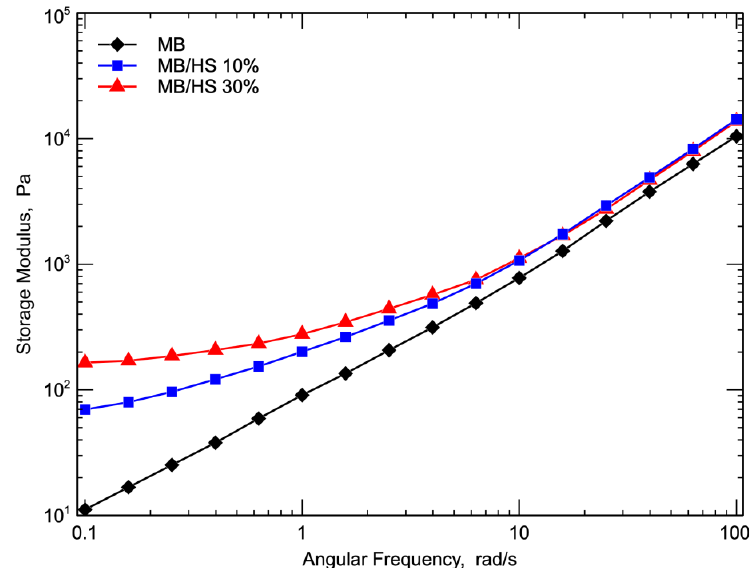
Figure 6. Storage modulus as a function of frequency of MB and biocomposites.